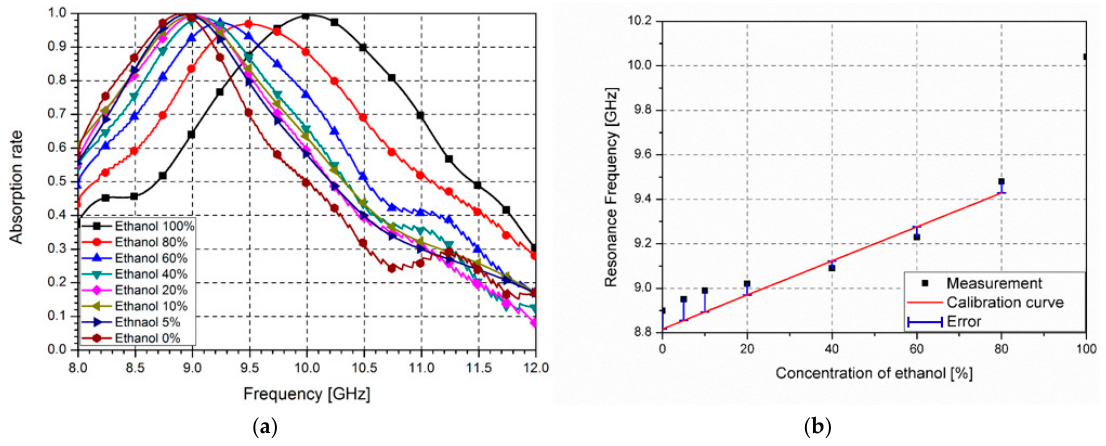
Figure 10. ( a ) Measured absorption rates with different concentrations of ethanol and ( b ) relationship of the resonance frequency and the concentration of ethanol with the calibration curve of y = 7.65 × 10 − 3 x + 8.817 in GHz.